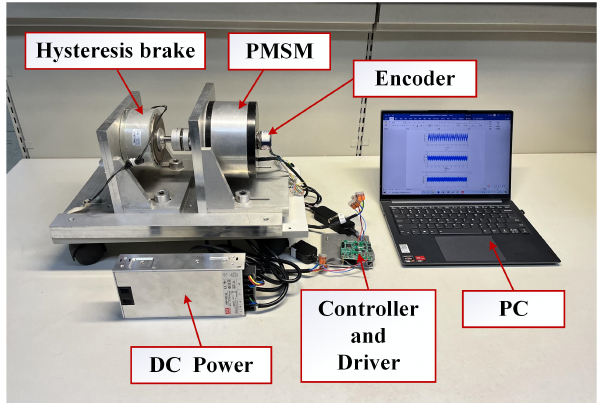
Figure 7. Structure diagram of the PMSM servo system based on SADRC.